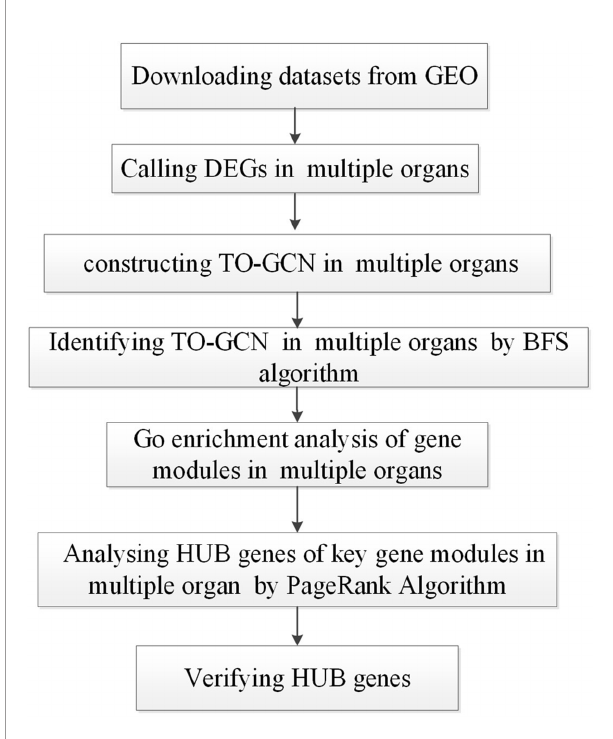
FIGURE 1 | The overall fl ow chart of the data analysis conducted in this